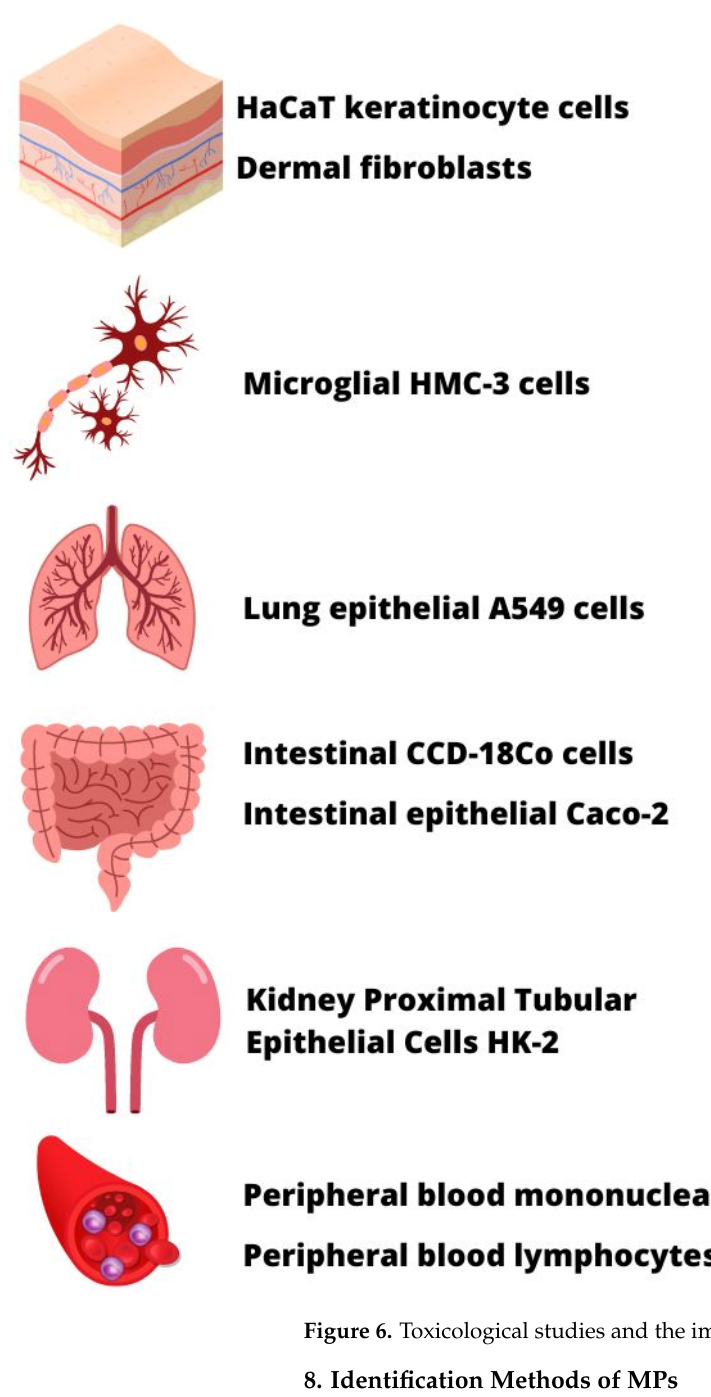
Figure 6. Toxicological studies and the implication of MPs contamination on human health.